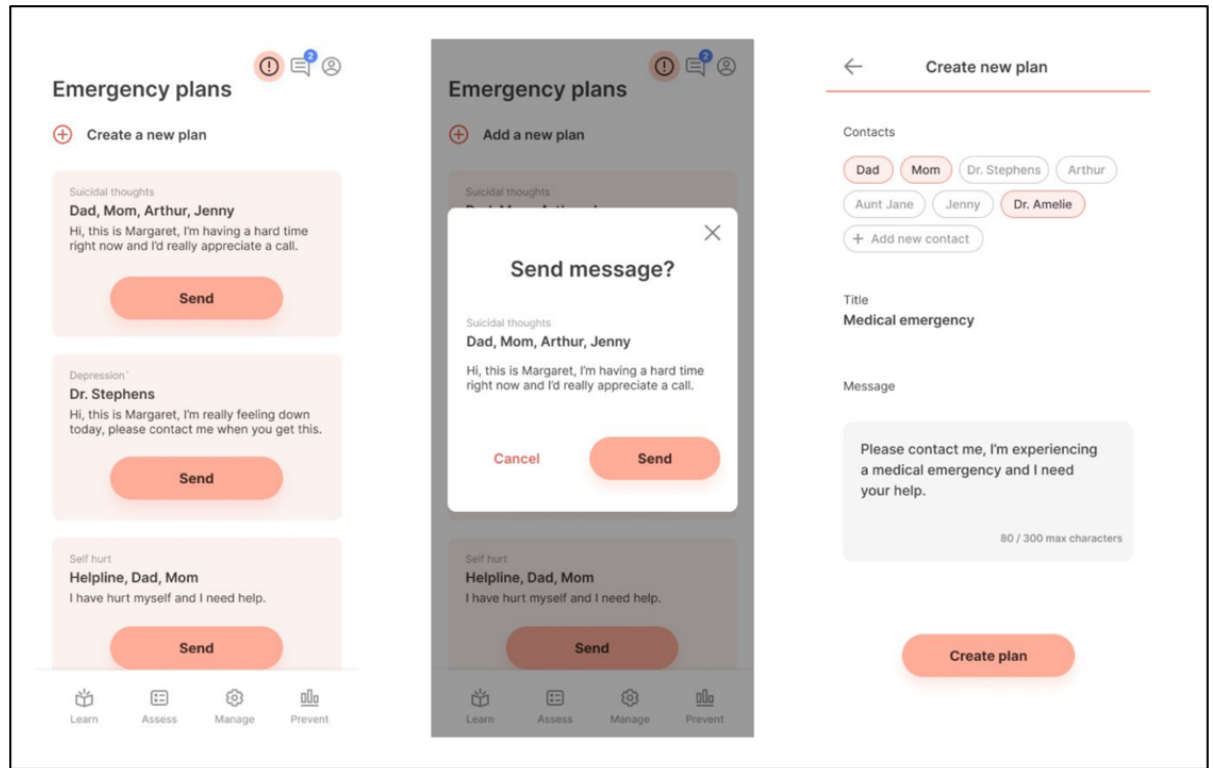
Figure 5. Example of one aspect of the safety planning activity as seen in mindLAMP.